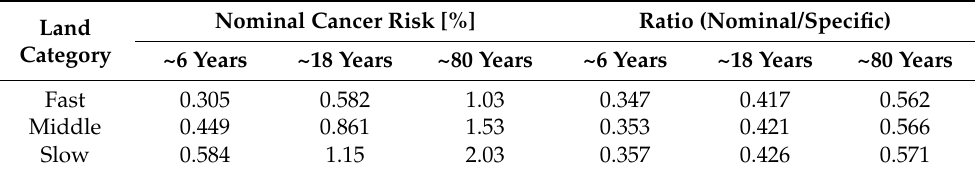
Table 4. Nominal cancer risks estimated by using the nominal risk coefficients of ICRP [6] and the ratios of those nominal risks to the specific risks of a female person calculated in this study (Table 3) for three areas having different land-surface